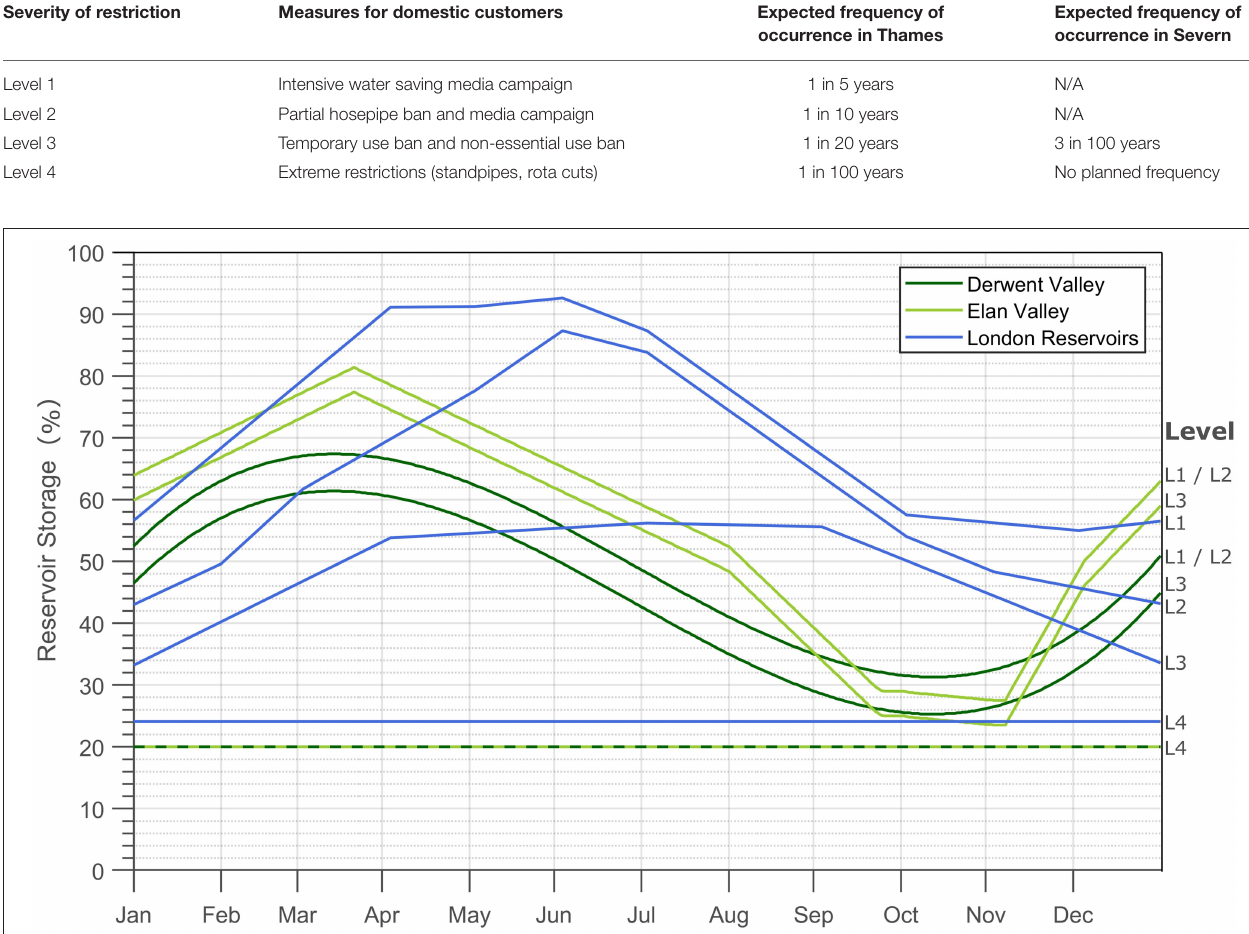
FIGURE 3 | Control diagram for Derwent Valley, Elan Valley, and London Reservoirs showing reservoir levels resulting in water restrictions to public water